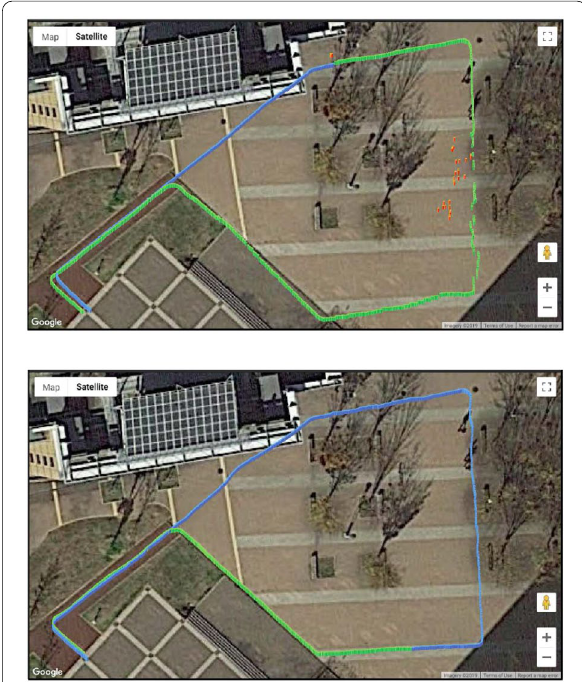
Fig. 14 Measured trajectory by the RTK-GPS (upper side) and the QZSS (lower side) are described by markers. The blue and green markers indicate the fixed and float solutions, respectively, and the orange markers indicate independent solutions